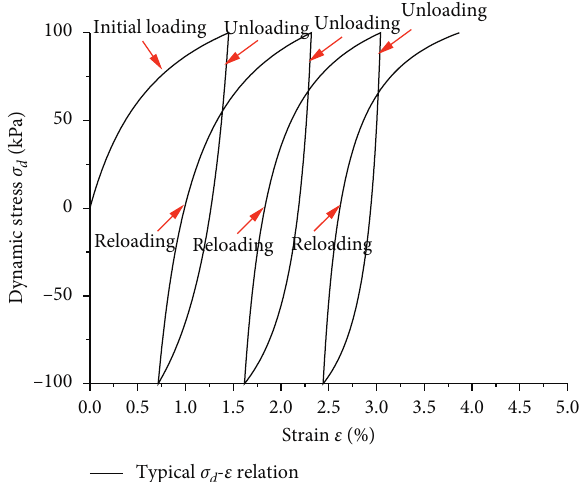
Figure 1: Typical stress-strain behaviour under a cyclic